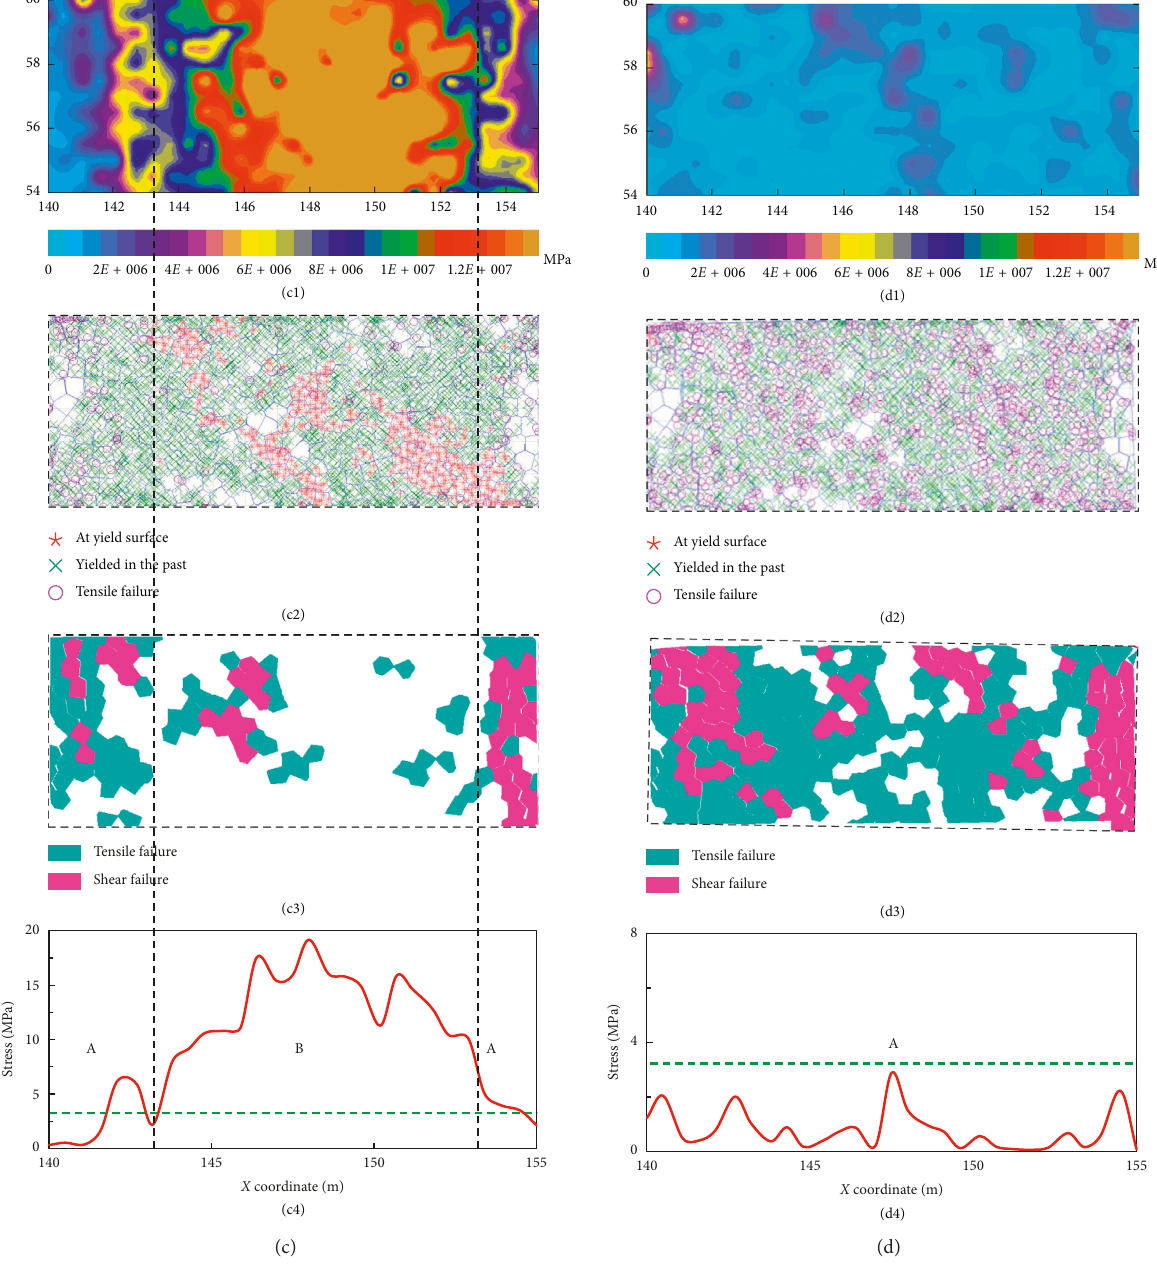
Figure 11: Integrated graph showing pillar failure process. (a) After excavation of three rooms in #4 seam. Panel in #6 seam advancing by (b) 50m, (c) 80 m, and (d) 110m. A: fracture zone (plastic zone); B: load-bearing zone (transition zone); C: elastic zone (intact